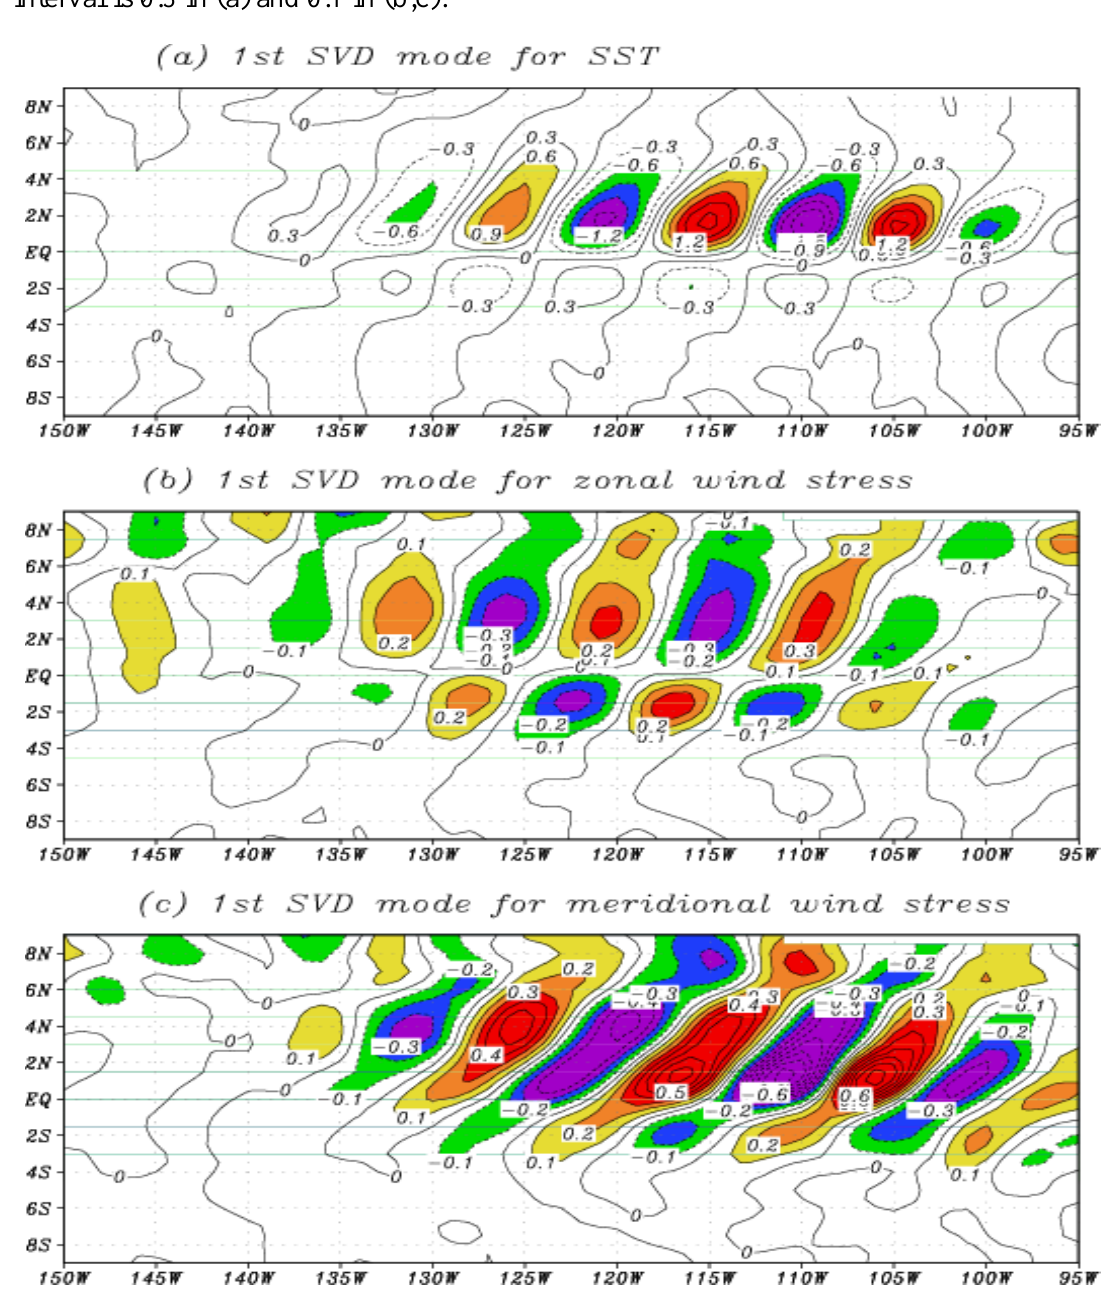
, and for ( b ) zonal TIW